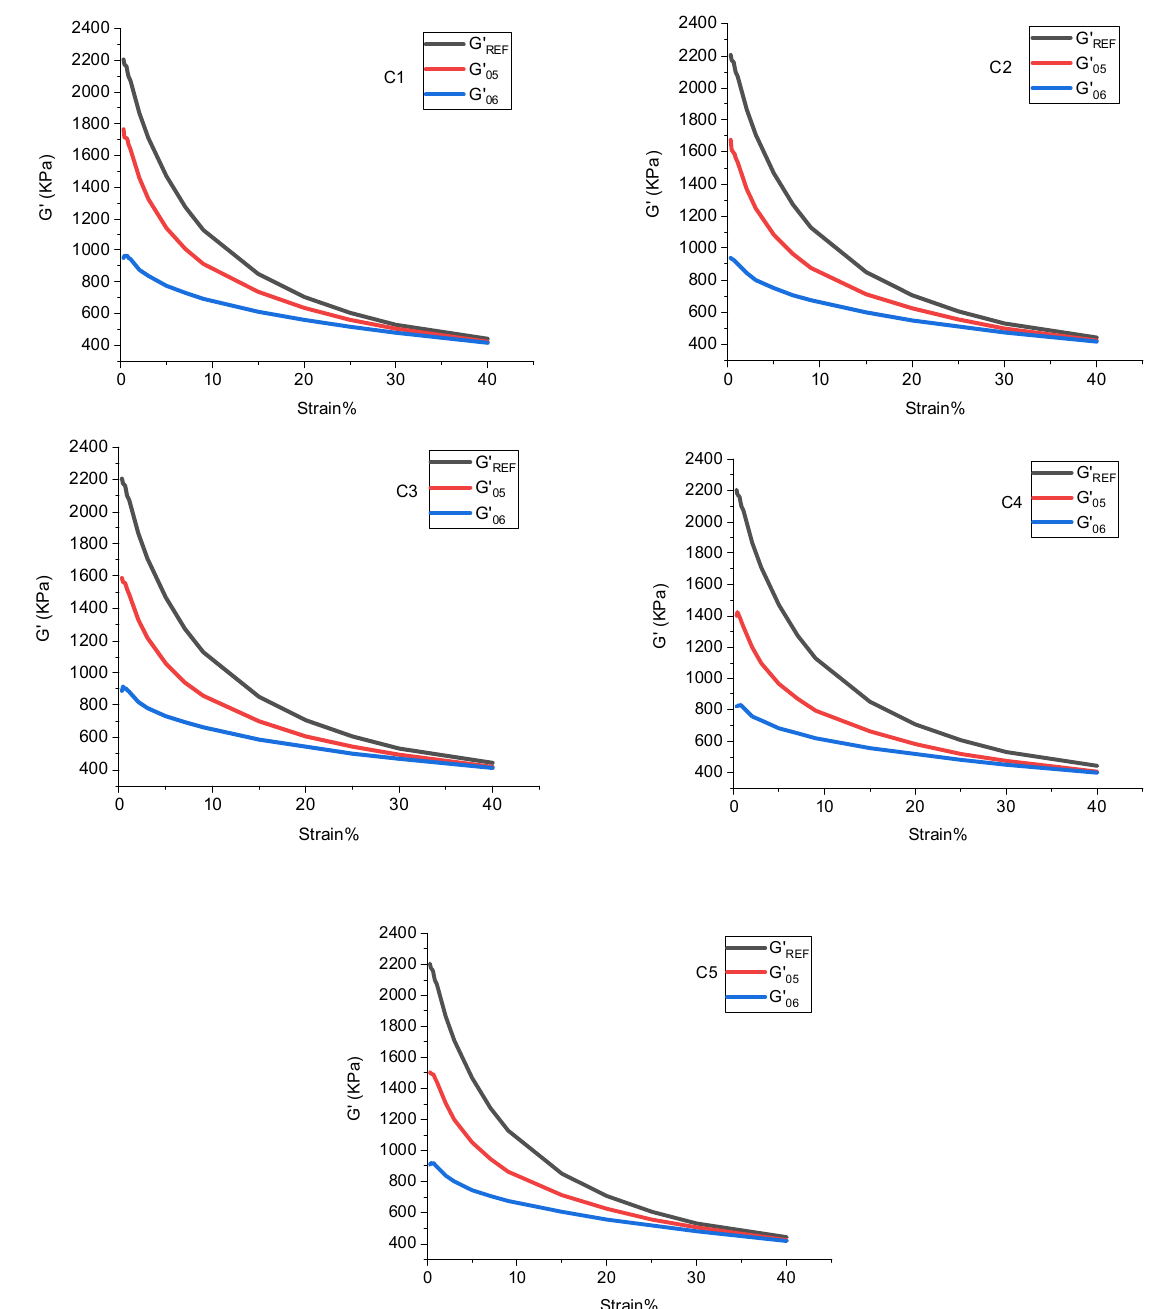
Figure 8. Distributions of the silanization reaction degree.